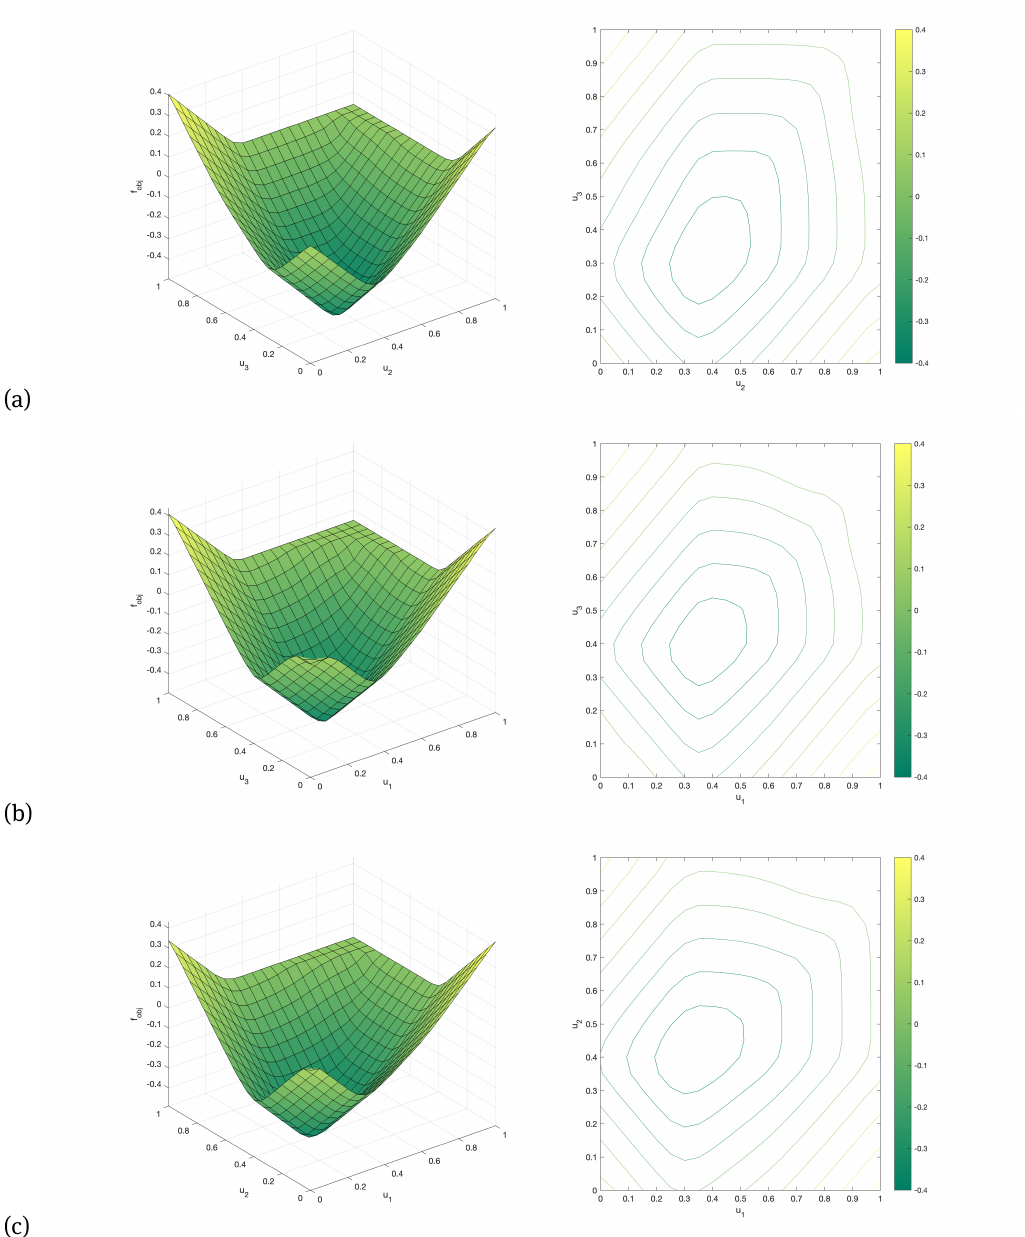
Figure 4: Values and contour plots of the objective function f obj for p = (9, 46.1) and for the marginals restricted on (a) u 1 = 0.4 , (b) u 2 = 0.3 , (c) u 3 = 0.4 ; Setting